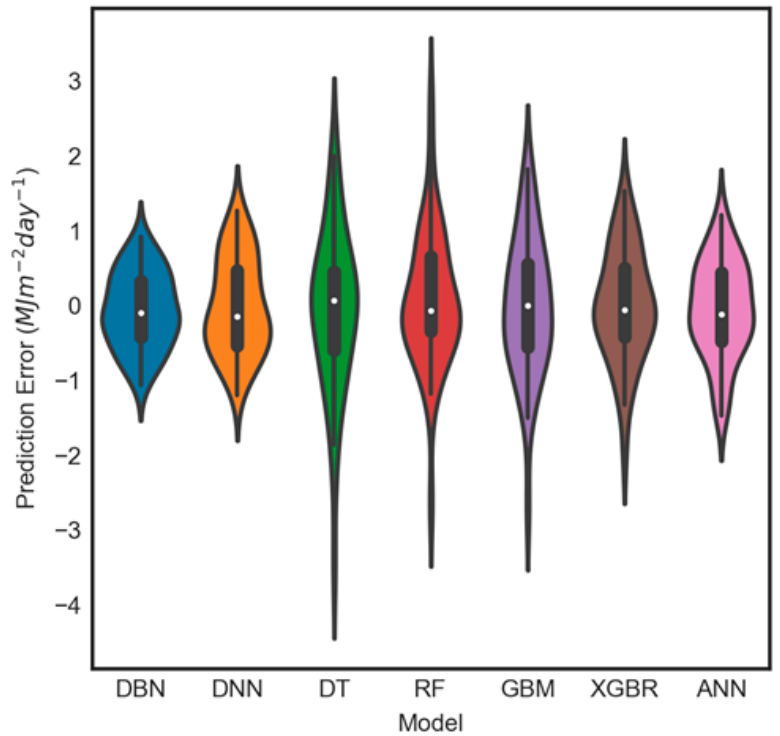
Figure 6. Violin plots of the prediction error ( PE ) generated by deep learning models (i.e., DBN 10 and DNN2 Nadam ) compared with single hidden layer neuronal and decision tree-based models in the testing phase.